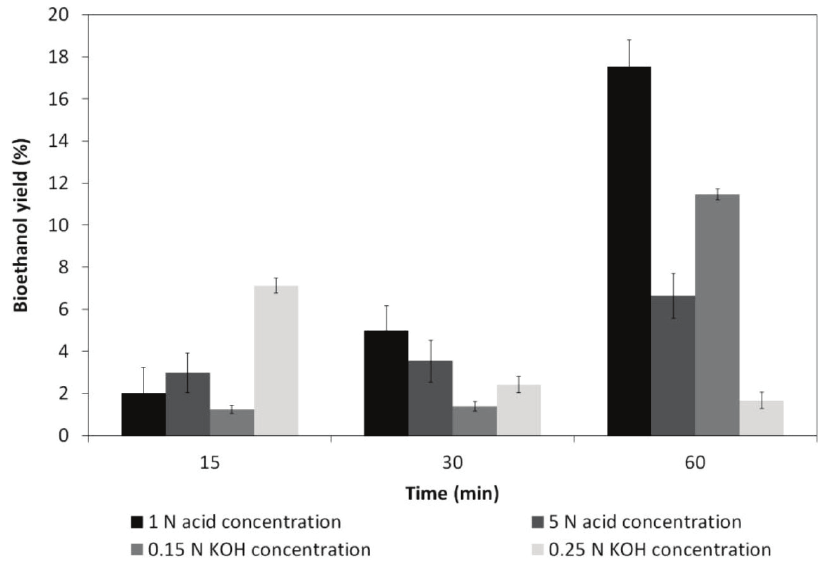
Fig. 4 – Effect of pre-treatment time on bioethanol yield (1 N and 5 N H 0.25 N KOH, pre-treatment temperature: 100